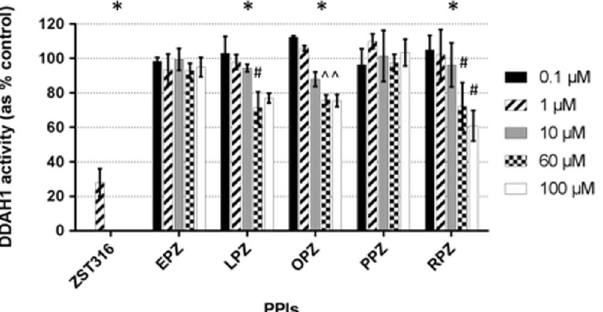
Figure 2. Concentration dependent inhibition of DDAH1 by ZST316 (positive control), esomeprazole (EPZ), lansoprazole (LPZ), omeprazole (OPZ), pantoprazole (PPZ) and rabeprazole (RPZ). Residual DDAH1 activity is reported as percentage of control activity. Each data point represents the mean of at least two single experiments. Error bars represent the standard deviation. * P < 0.01 for trend; # P < 0.05 vs. baseline; ^ P < 0.01 vs. baseline.